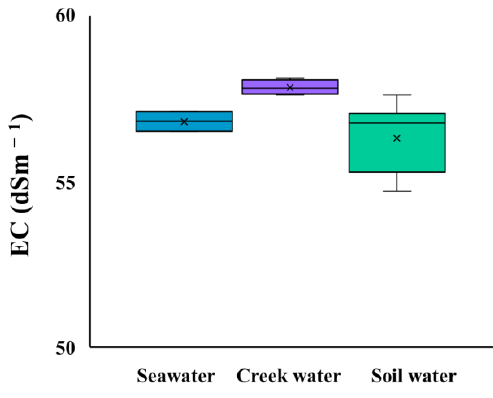
Figure 4. Comparison of EC of seawater, creek water, and soil water in Site B on Moucha Island, Djibouti ( p < 0.05).